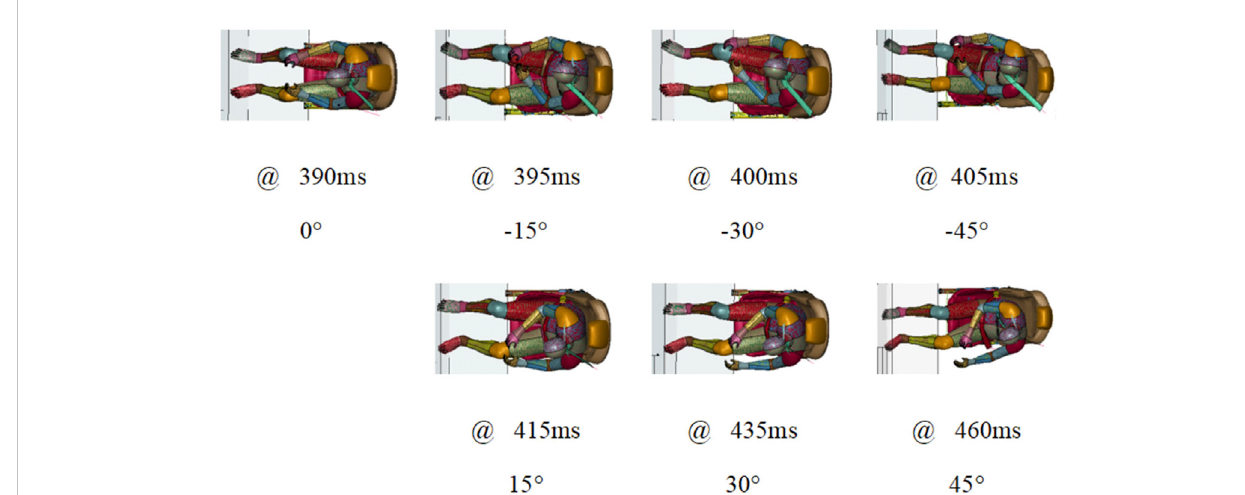
FIGURE 11 Top view of occupant ’ s maximum displacement at various seating arrangement.